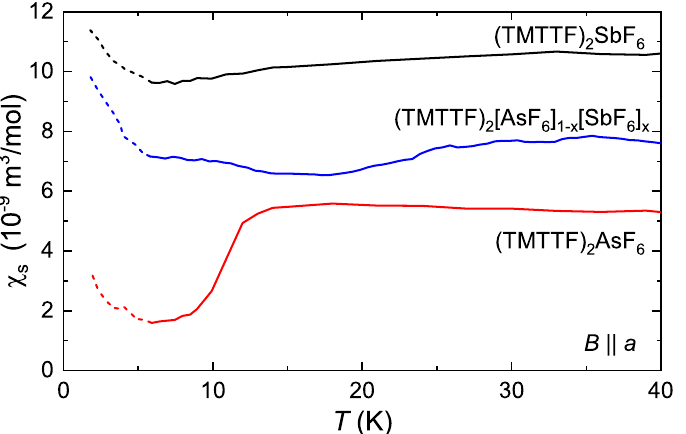
Figure 3. Temperature dependence of the magnetic susceptibility χ s ( T ) for (TMTTF) 2 X with X = SbF 6 , [AsF 6 ] 1 − x [SbF 6 ] x ( x = 0.3) and AsF 6 measured by a SQUID magnetometer. In all cases, the pronounced Curie tail below 6 K has not been subtracted (dashed region). The magnetic field was B = 0.5 T for the alloy and 1 T for the two pure compounds; the single crystals are oriented with B (cid:107) a . The curves of X = SbF 6 and [AsF 6 ] 1 − x [SbF 6 ] x are vertically shifted by a positive offset for clarity reasons. The spin-Peierls transition in (TMTTF) 2 AsF 6 can be clearly seen at T SP = 13 K, whereas the antiferromagnetic transition at T N = 8 K is barely visible for (TMTTF) 2 SbF 6 . For the alloy (TMTTF) 2 [AsF 6 ] 1 − x [SbF 6 ] x , we cannot identify any transition within the accessible temperature range ( T > 1.8 K).